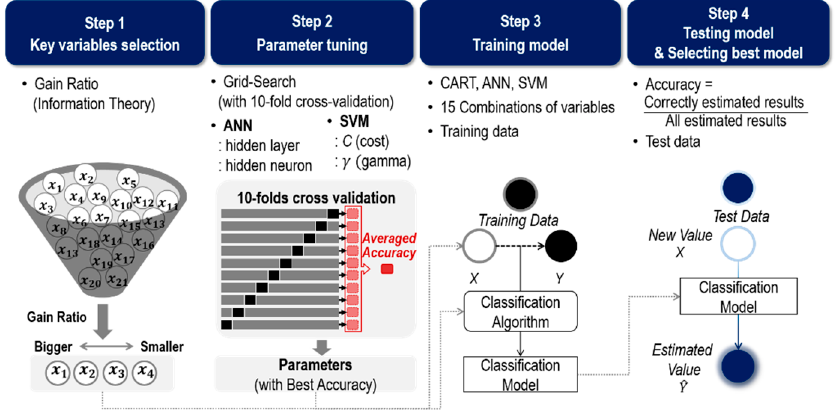
Figure 4. Diagram of seasonal short-term occupancy estimation model selection process.